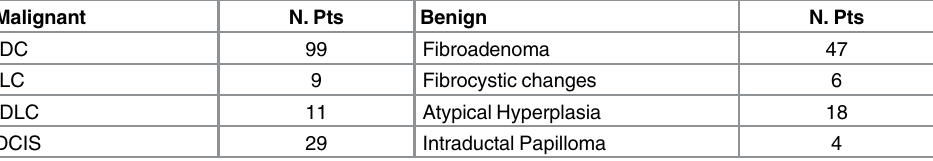
Table 1. Pathologic diagnosis of all tumors.